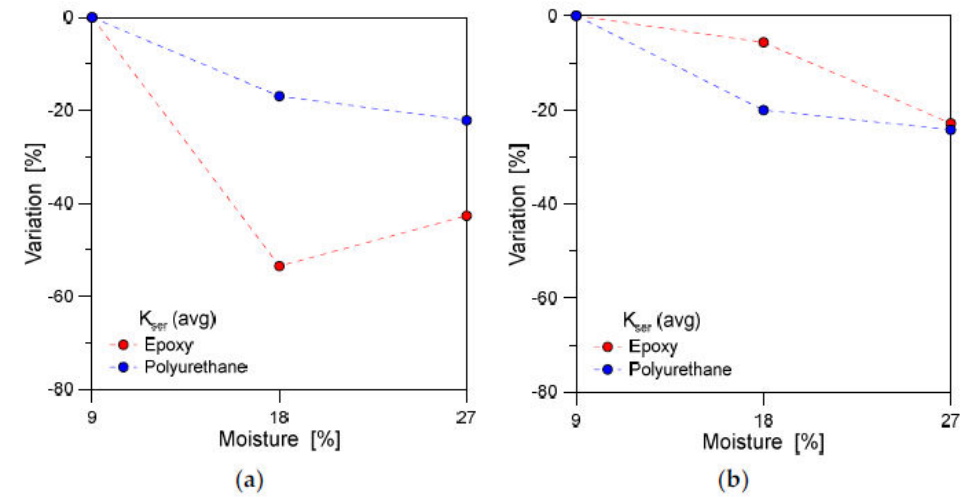
Figure 10. Average experimental variation of slip modulus K ser for specimens with ( a ) parallel or ( b ) perpendicular rod-to-grain